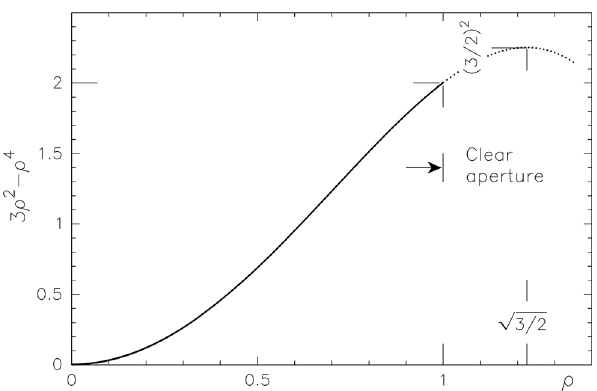
Figure 3: The freeform primary mirror, of biaxial symmetry, is generated by homothetic ellipses having principal lengths in a cos i -ratio. One shows that whatever x and y directions the null-power zone is outside the M1 clear-aperture, and in a geometrical ratio 𝜌 = √ 3 / 2 𝜌 ≃ 1 . 224 𝜌 0 𝑚𝑎𝑥 𝑚𝑎𝑥